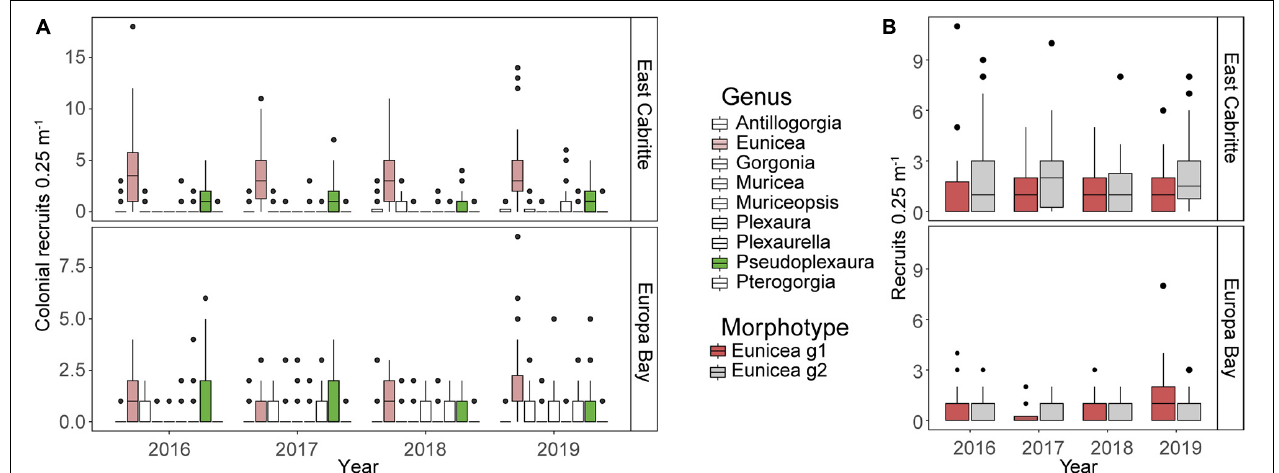
FIGURE 5 | Boxplots comparing the median, 25th and 75th percentiles abundances of colonial recruits 0.25 m − 2 at East Cabritte and Europa Bay from 2016 to 2019. (A) compares abundances among the nine genera present at the study sites. Eunicea and Pseudoplexaura , highlighted in color, were the two most abundant genera at both sites, but they were more abundant at East Cabritte than at Europa Bay ( p < 0.001). Genera are alphabetically ordered in the x -axis. (B) depicts the abundances of Eunicea spp. recruits with two different morphological traits ( Eunicea g1: recruits with prominent calyces and Eunicea g2: recruits without prominent calyces), with Eunicea g2 more abundant at East Cabritte, whereas Eunicea g1 were more abundant at Europa Bay ( p < 0.001).